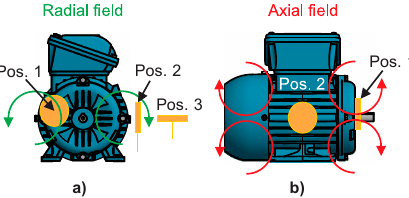
Figure 1. Magnetic stray flux components: ( a ) radial stray flux; ( b ) axial stray flux.